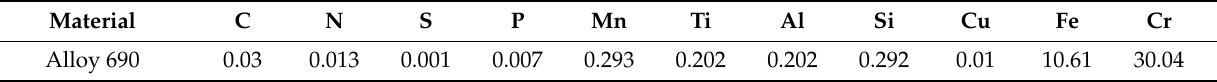
Table 1. Chemical compositions of Alloy 690 (wt. %).